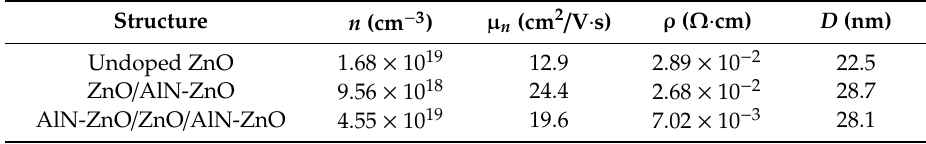
Table 2. Carrier concentration, mobility, and resistivity of the undoped ZnO film deposited onto the substrate with and without an AlN-ZnO (20%) bu ff er layer as well as the ZnO film sandwiched in the AlN-ZnO cosputtered films, after annealing at 700 ◦ C under vacuum ambient for 30 min (the crystal size, D , evaluated from the full width at half maximum (FWHM) of the ZnO (002) phase in the XRD patterns also is given).